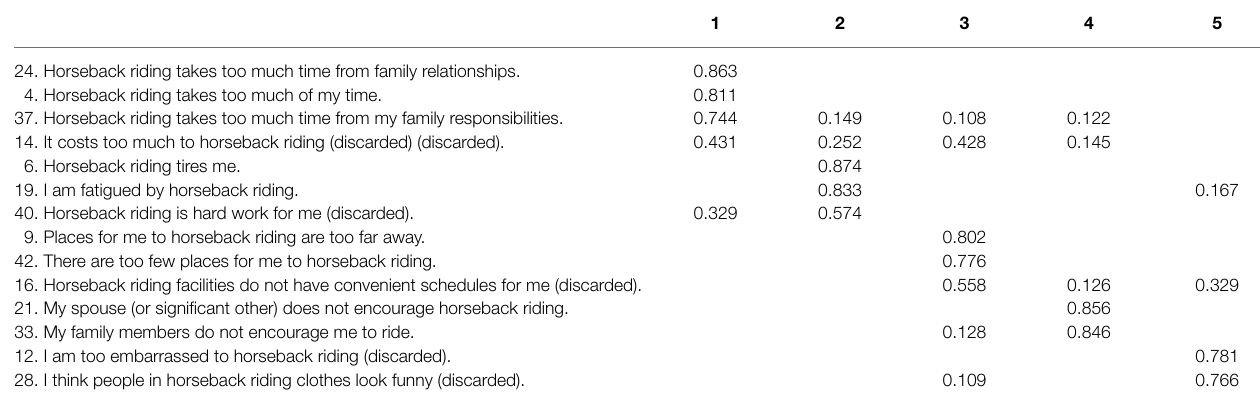
TABLE 2 | Barriers indicators’ Principal Component Analysis.